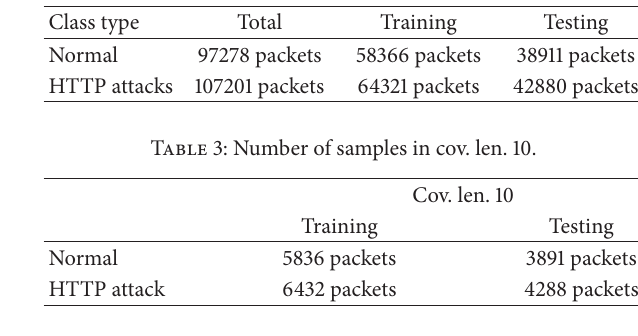
Table 4: Number of samples in cov. len. 50.